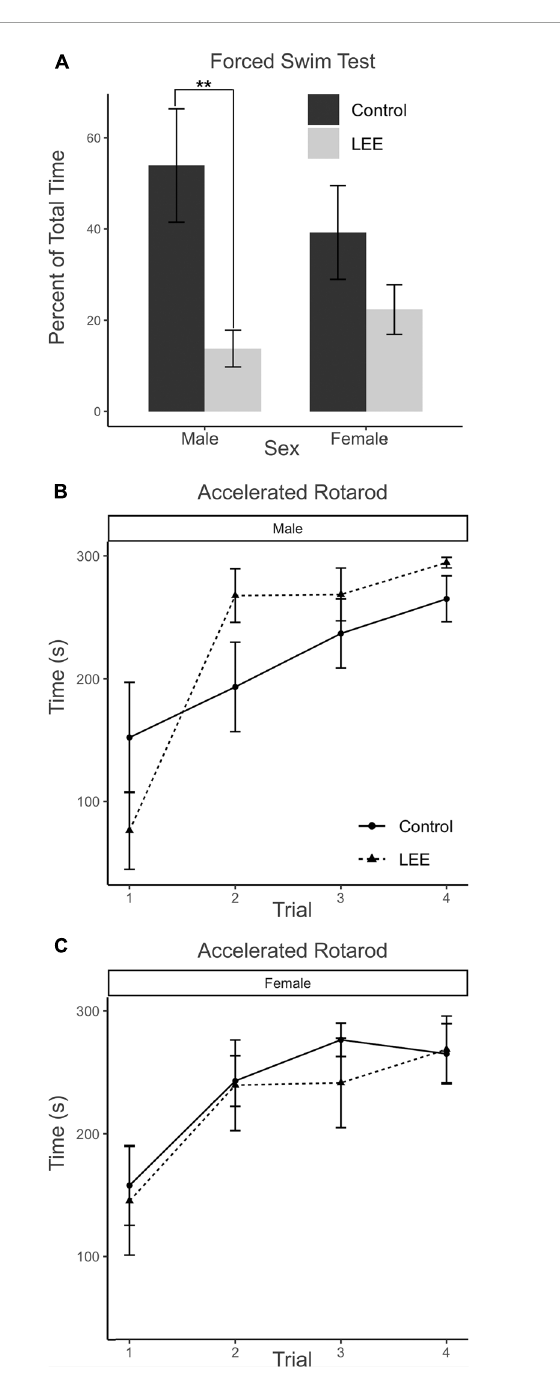
FIGURE11 Behavioral assays at P30: FST and AR. (A) Male LEE pups ( p = 0.0049) spent less time immobile than male controls in the FST. No significant differences in time spent immobile for females ( p = 0.3588) on the FST ( N = 34). No significant differences in performance on the AR for males (B) or females (C) ( N = 42). Data expressed as mean ±